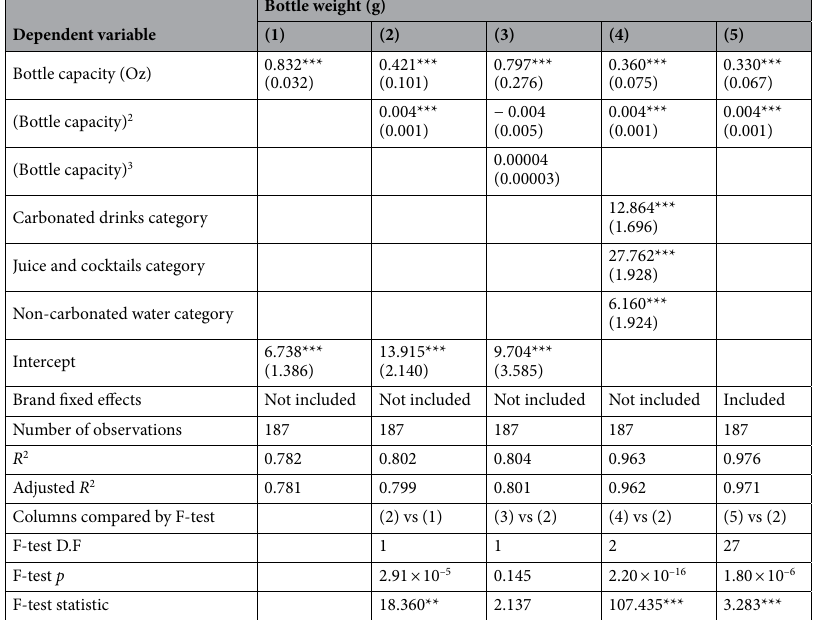
Table 1. Ordinary least square estimates of the effect of bottle and product attributes on bottle weight. Numbered columns correspond to different model specifications. Numbers in parentheses are standard errors. F-tests compare model specifications. *Pr ( >|t|) < 0.1; **Pr( >|t|) < 0.05; ***Pr( >|t|) < 0.01.